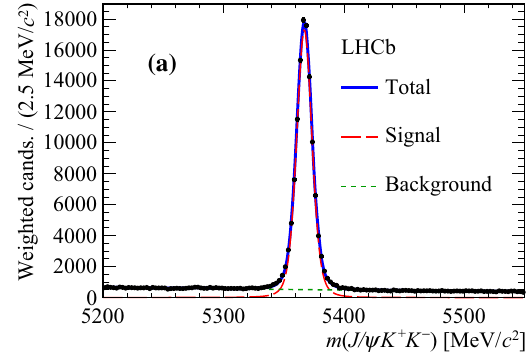
bution from B 0 → J /ψ K + K − decays is not shown separately due to its small size. b Distribution of K + K − invariant mass from selected B 0 s → J /ψ K + K − decays. The background is subtracted using the sPlot method. The dashed blue lines define the boundaries of the six m ( K + K − ) bins that are used in the